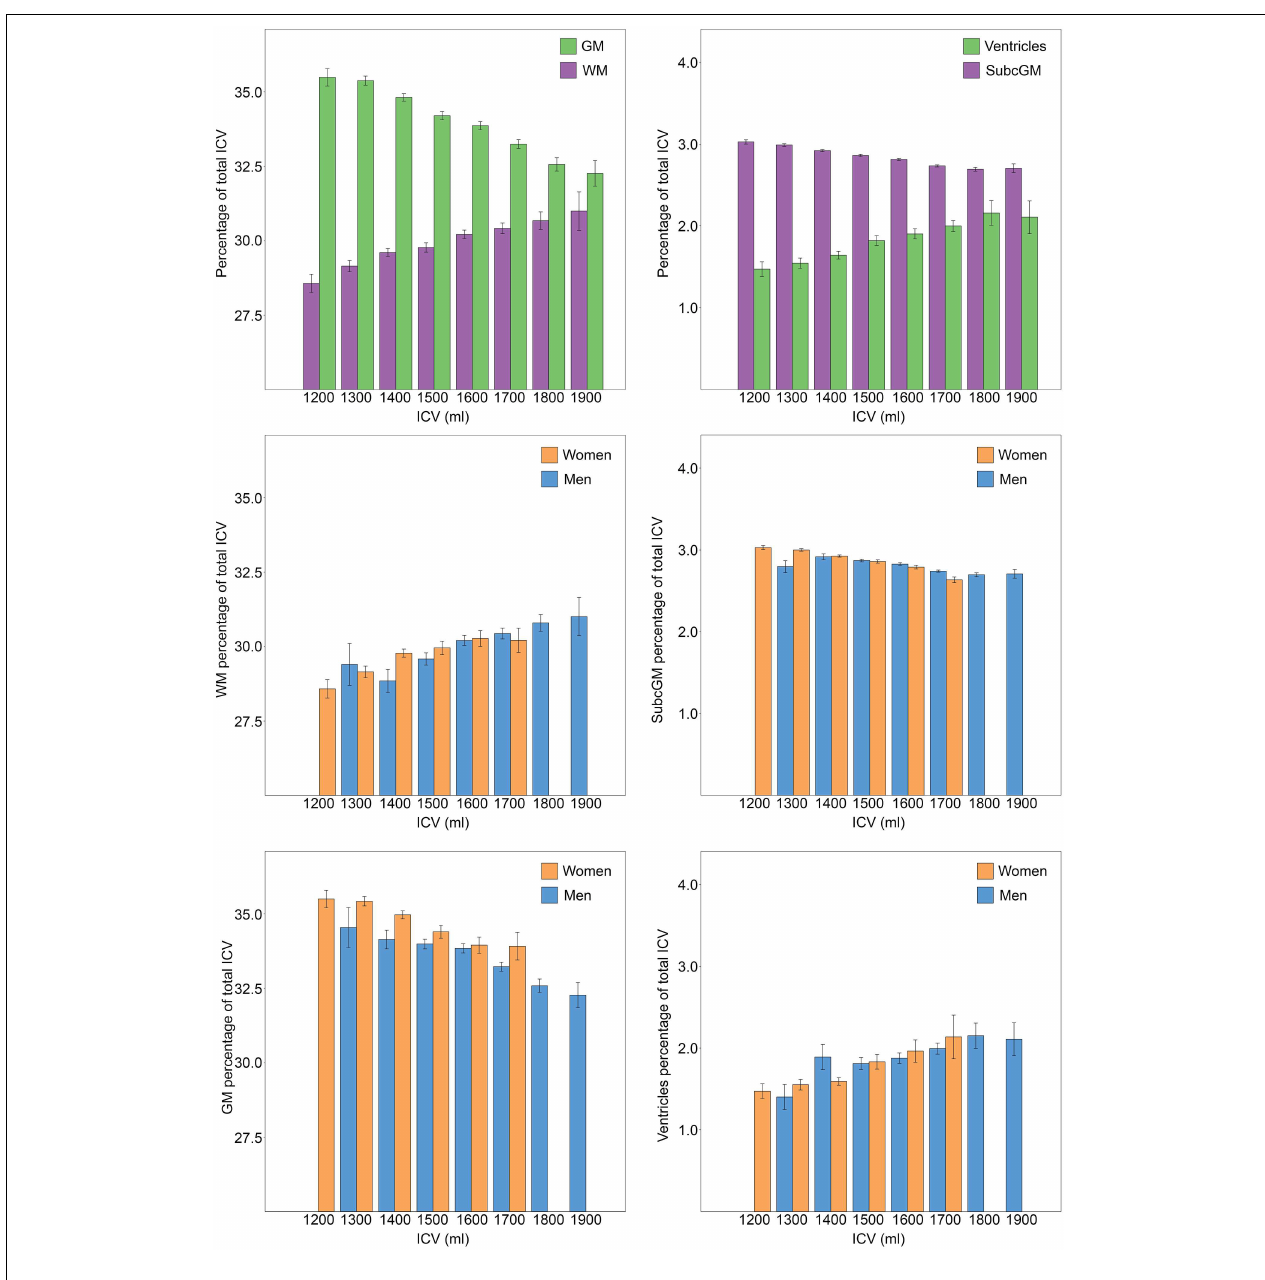
FIGURE 5 | Relationship between ICV and brain tissue types. ICV was stratified in groups of 100ml and groups with less than five participants were excluded. The bars illustrate the relative size (% of ICV) of different brain tissue types with the standard error superimposed. The two top charts are from analysis performed on men and women combined ( n = 966 ). A significant effect of ICV was found for all brain tissue types; the relative size of cortical and subcortical